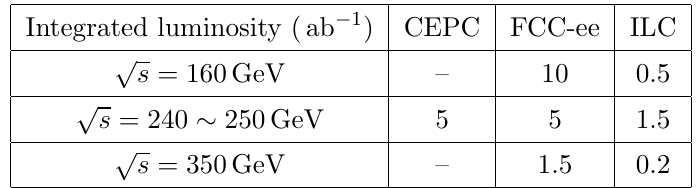
Table 1 . The projected/updated integrated luminosities at the CEPC [31], FCC-ee [32, 33] and ILC